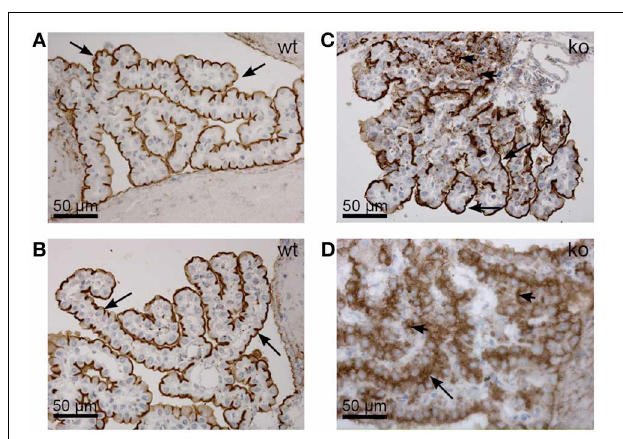
FIGURE 5 | Distribution of ezrin in the choroid plexus epithelium of slc4a10 wt and ko mice. (A–D) Labeling of choroid plexus brain sections with peroxidase conjugated anti-ezrin antibodies from slc4a10 wt (A,B) and ko mice (C,D) . The two examples from slc4a10 ko mice indicate the range of ezrin expression. Arrows indicate the luminal membrane, while arrowheads indicate the intracellular distribution of ezrin in slc4a10 ko.